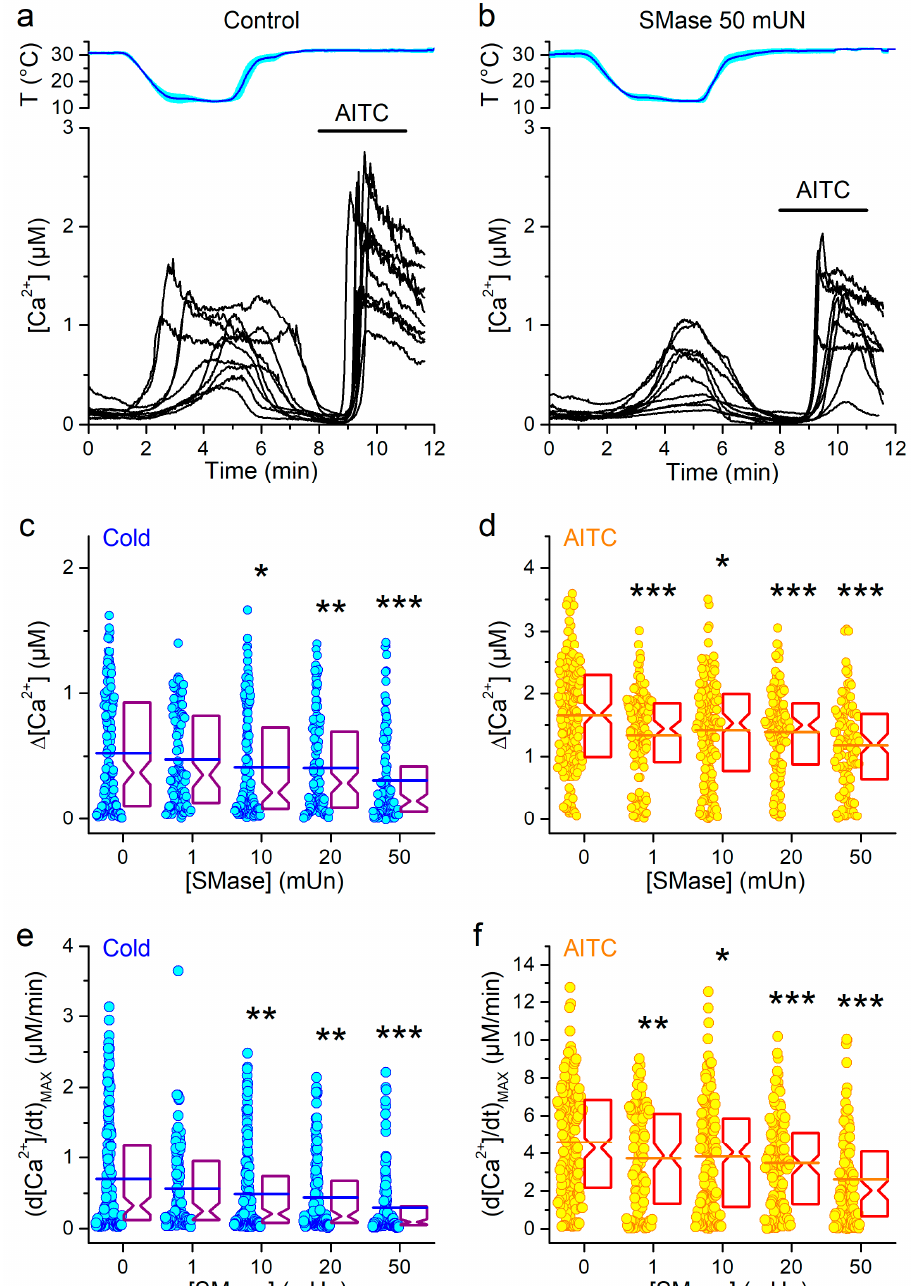
Figure 2. Effects of SMase pretreatment on mTRPA1 responses to cold. ( a and b ) Representative traces of [Ca 2+ ] change induced by cold in the control condition ( a ) and after pretreatment with 50 mUN SMase ( b ). Application of AITC (100 µM) was used as control for mTRPA1 activation. ( c and d ) Amplitudes of [Ca 2+ ] responses evoked by cold ( c ) and AITC ( d ) in control condition ( n = 183) or after pretreatment with 1 ( n = 126), 10 ( n = 164), 20 ( n = 135) or 50 mUN ( n = 111) of SMase. ( e and f ) Maximal amplitudes of the first time derivative of the intracellular Ca 2+ signal elicited by cold ( e ) and AITC ( f ) in control condition or after treatment with 1, 10, 20 or 50 mUN of MCD (the n numbers are the same as in panels c and d). The symbols *, ** and *** indicate p < 0.05, p < 0.01 and p < 0.001, respectively; Kolmogorov–Smirnov test.